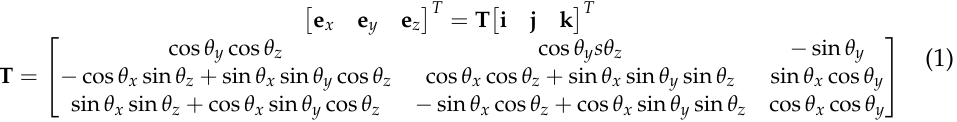
Figure 1. Tait–Bryan transformation. The Tait-Bryan transformation matrix T can be derived from the three sequential co- ordinate transformations